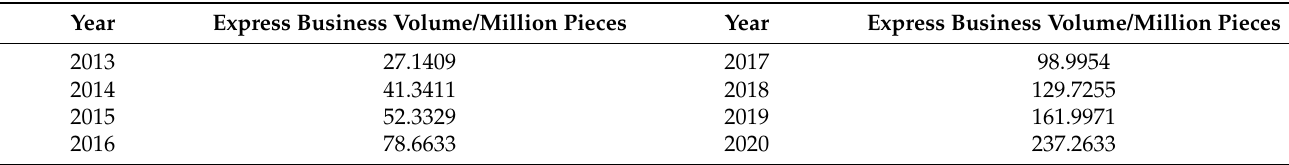
Table 1. The 2013–2020 express business statistics table in Changchun. Table 1. The 2013 – 2020 express business statistics table in Changchun .